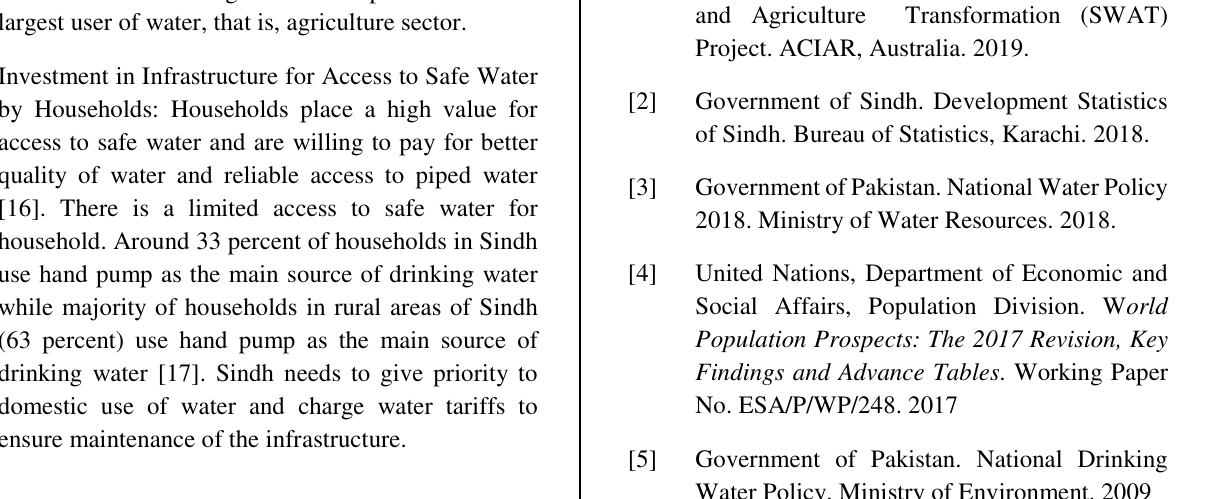
Change in Agricultural value-added to GDP (percent)